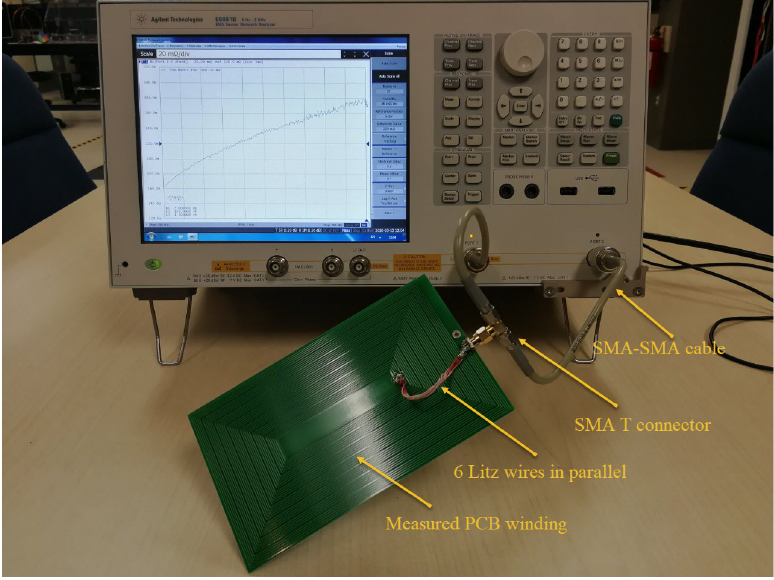
Figure 6. Measurement setup. Table 4. DC resistances of PCB